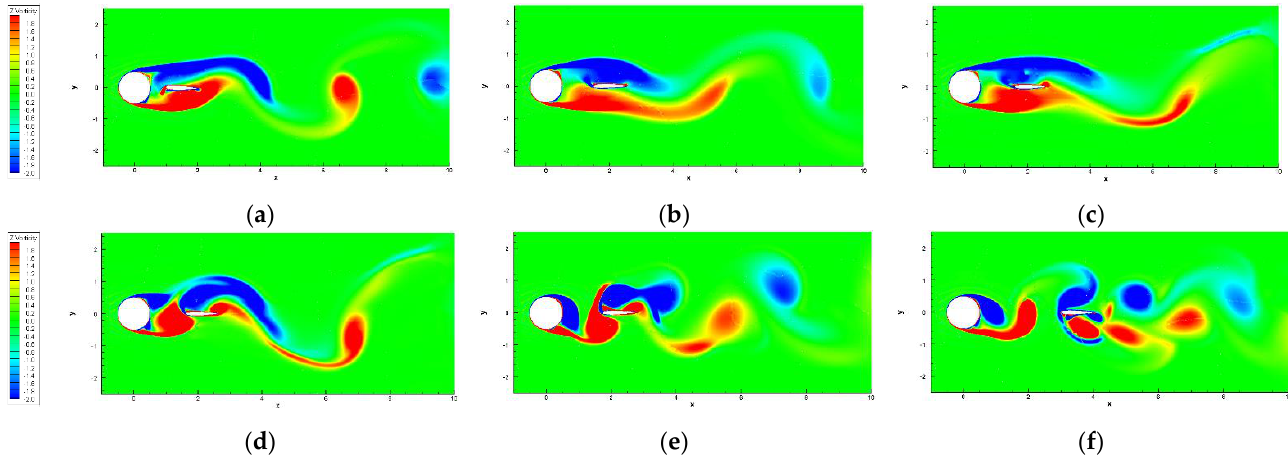
Figure 14. Vorticity contour with different x / D : ( a ) x / D = 1.0; ( b ) x / D = 1.5; ( c ) x / D = 1.6; ( d ) x / D = 1.625; ( e ) x / D = 1.75; ( f ) x / D =